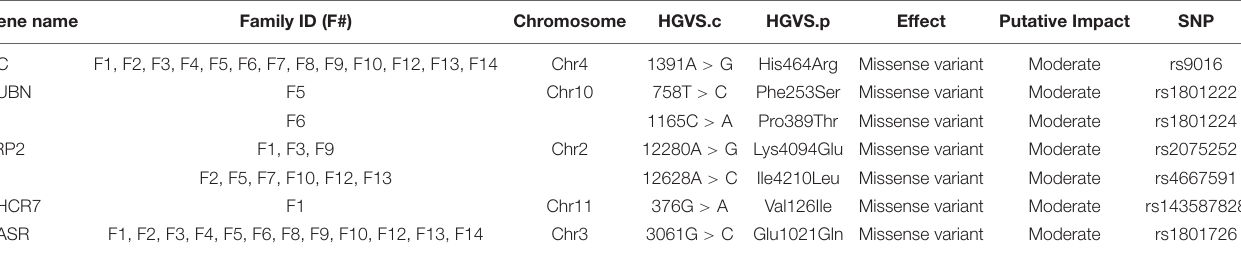
TABLE 1 | Filtered WES results of vitD-related gene variants among vitD-deficient families.